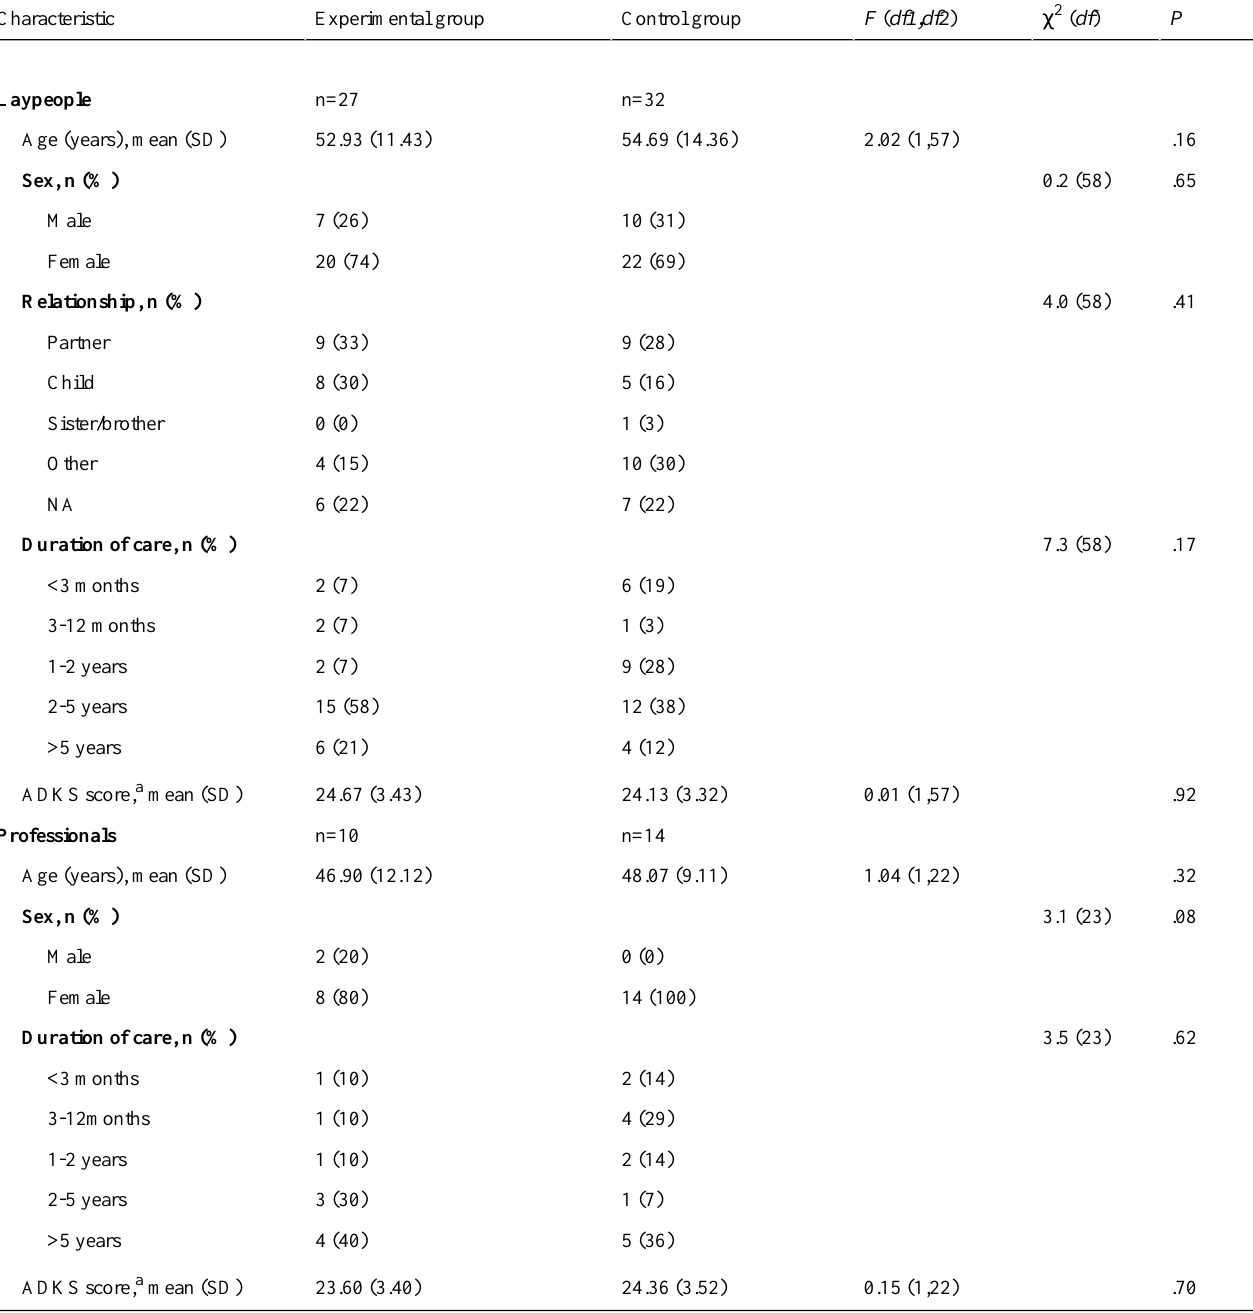
Table 1. Background characteristics of participants at baseline for laypeople (informal caregivers and volunteers) and professional caregivers that finished pretest and